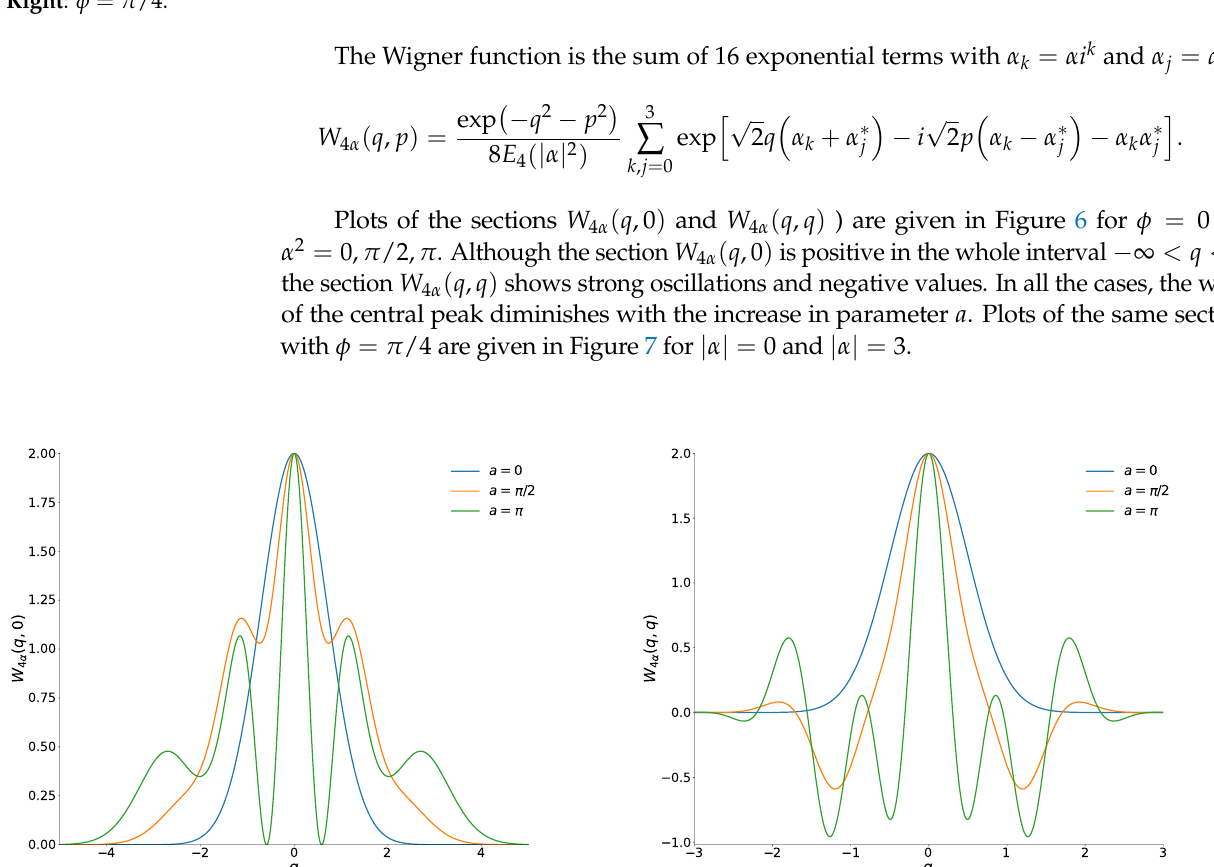
Figure 5. The coordinate probability density of OECS for different values of parameter a = | α | 2 and phase φ . Left : φ = 0. Right : φ = π /4.